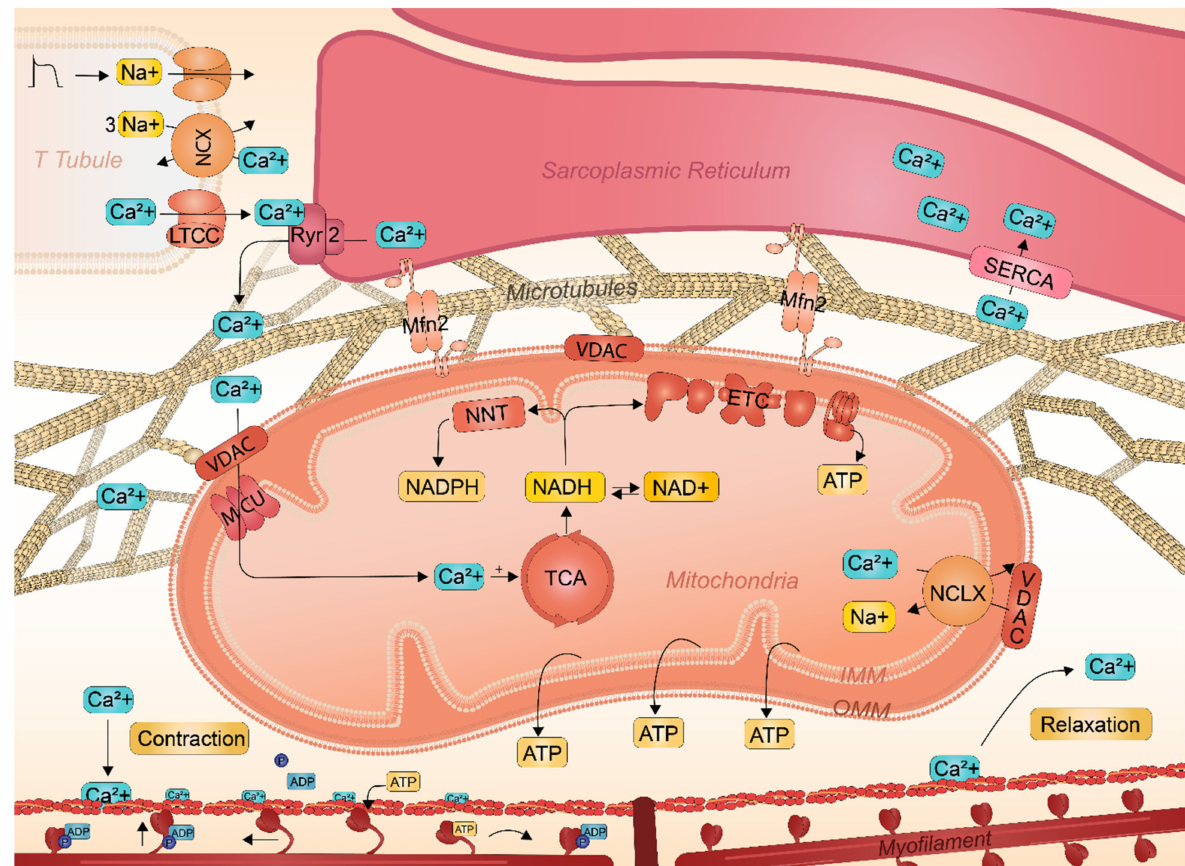
Figure 2. Schematic representation of Ca 2+ transient handling and contraction in atrial cardiomyocytes and the role of SR and mitochondria. An action potential activates the Ca 2+ channels in the T-tubule, resulting in an influx of Ca 2+ into the cardiomyocytes. Subsequently, Ca 2+ crosses the OMM through VDAC and is transported into the mitochondrial matrix via the MCU. Ca 2+ efflux from the matrix is mediated by the NCLX. Cytosolic Ca 2+ binds to cardiac troponin-C, which moves the troponin away from the actin binding site to form cross-bridges between actin and myosin. The myosin head binds to ATP and pulls the actin filaments towards the center of the sarcomere resulting in cardiomyocyte contraction. Dropping of the intracellular Ca 2+ concentration returns the troponin complex to the resting position, thereby effectively inhibiting cardiac contraction and initiating